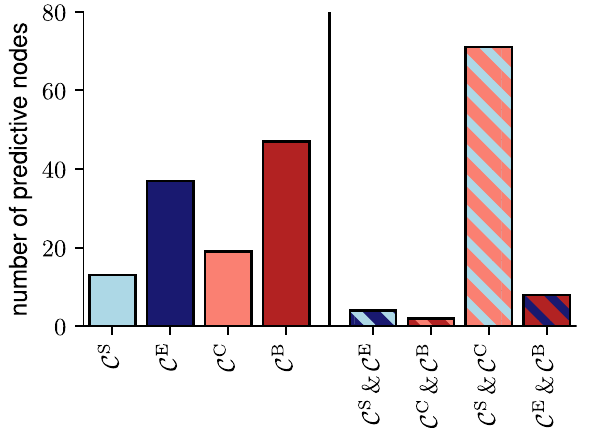
Figure 2. Predictive nodes as identified with only respective centralities or combinations of such. For example, S there are 13 nodes identified as predictive with C , that are not identified as predictive with the other three S E centralities, and 4 nodes identified as predictive with C and C , that are not identified as predictive with the S other two centralities. Different colours indicate different centralities (light blue: strength centrality C ; dark E C B blue: eigenvector centrality C ; light red: closeness centrality C ; dark red: betweenness centrality C ). Centrality indices considering local/global aspects of the evolving epileptic brain network are depicted in light/dark colour respectively, while strength-/path-based centrality indices are depicted in blue/red. Hatched bars indicate a combination of the respective centralities (see colours